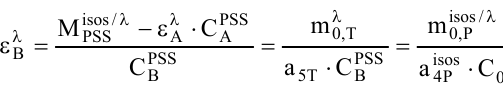
Figure 8. Absorption spectra of species A (plain line) and B (dashed line) for Scheme 6. The spectrum of B has been reconstructed using data from the elucidation method